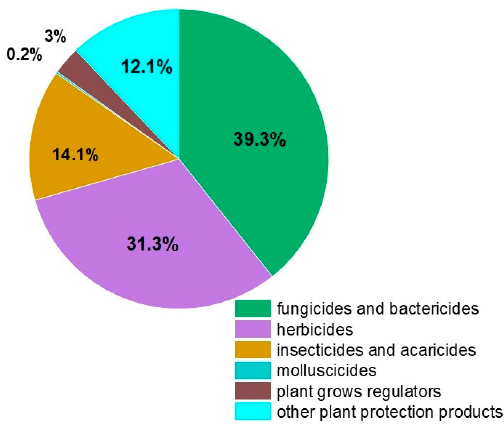
Figure 1. Categories of pesticide sales in the European Union in 2019 (adaptation from Eurostat Pesticide, http://appsso.eurostat.ec.europa.eu/nui/submitViewTableAction.do, accessed on 8 April